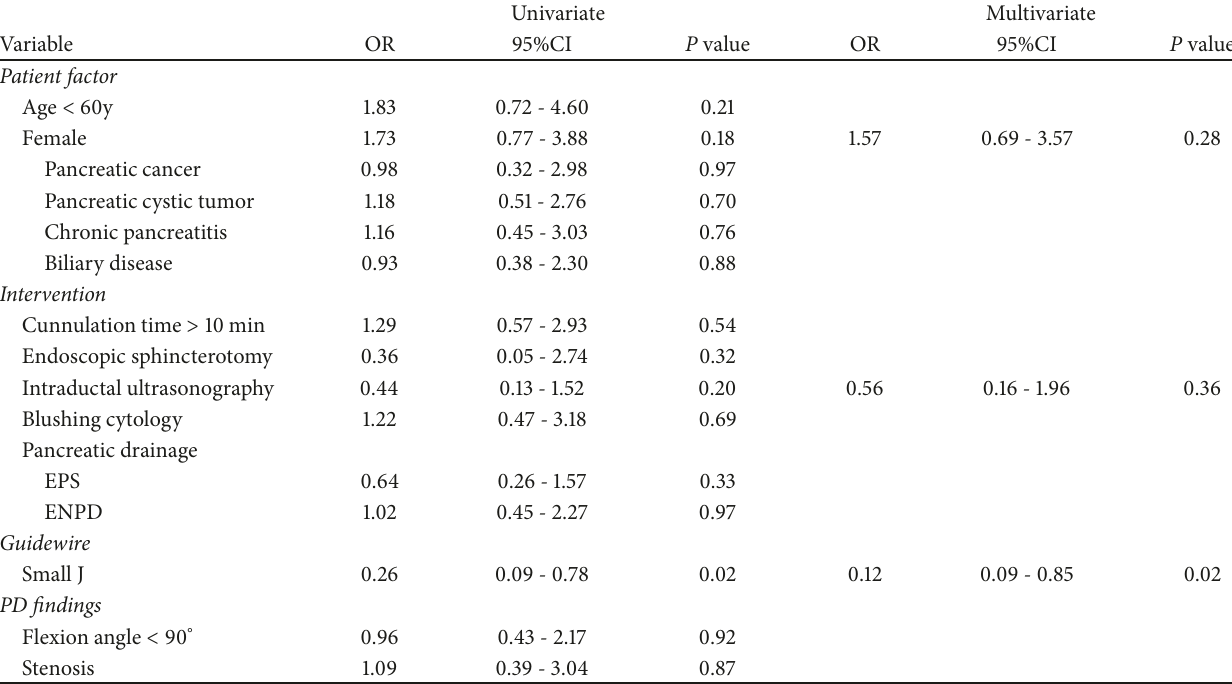
Table 5: Univariate and multivariate analysis of risk factors for post-ERCP pancreatitis. Univariate